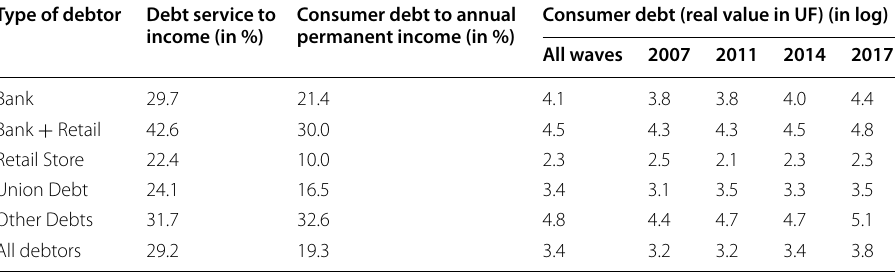
Average values for borrowers with positive debt